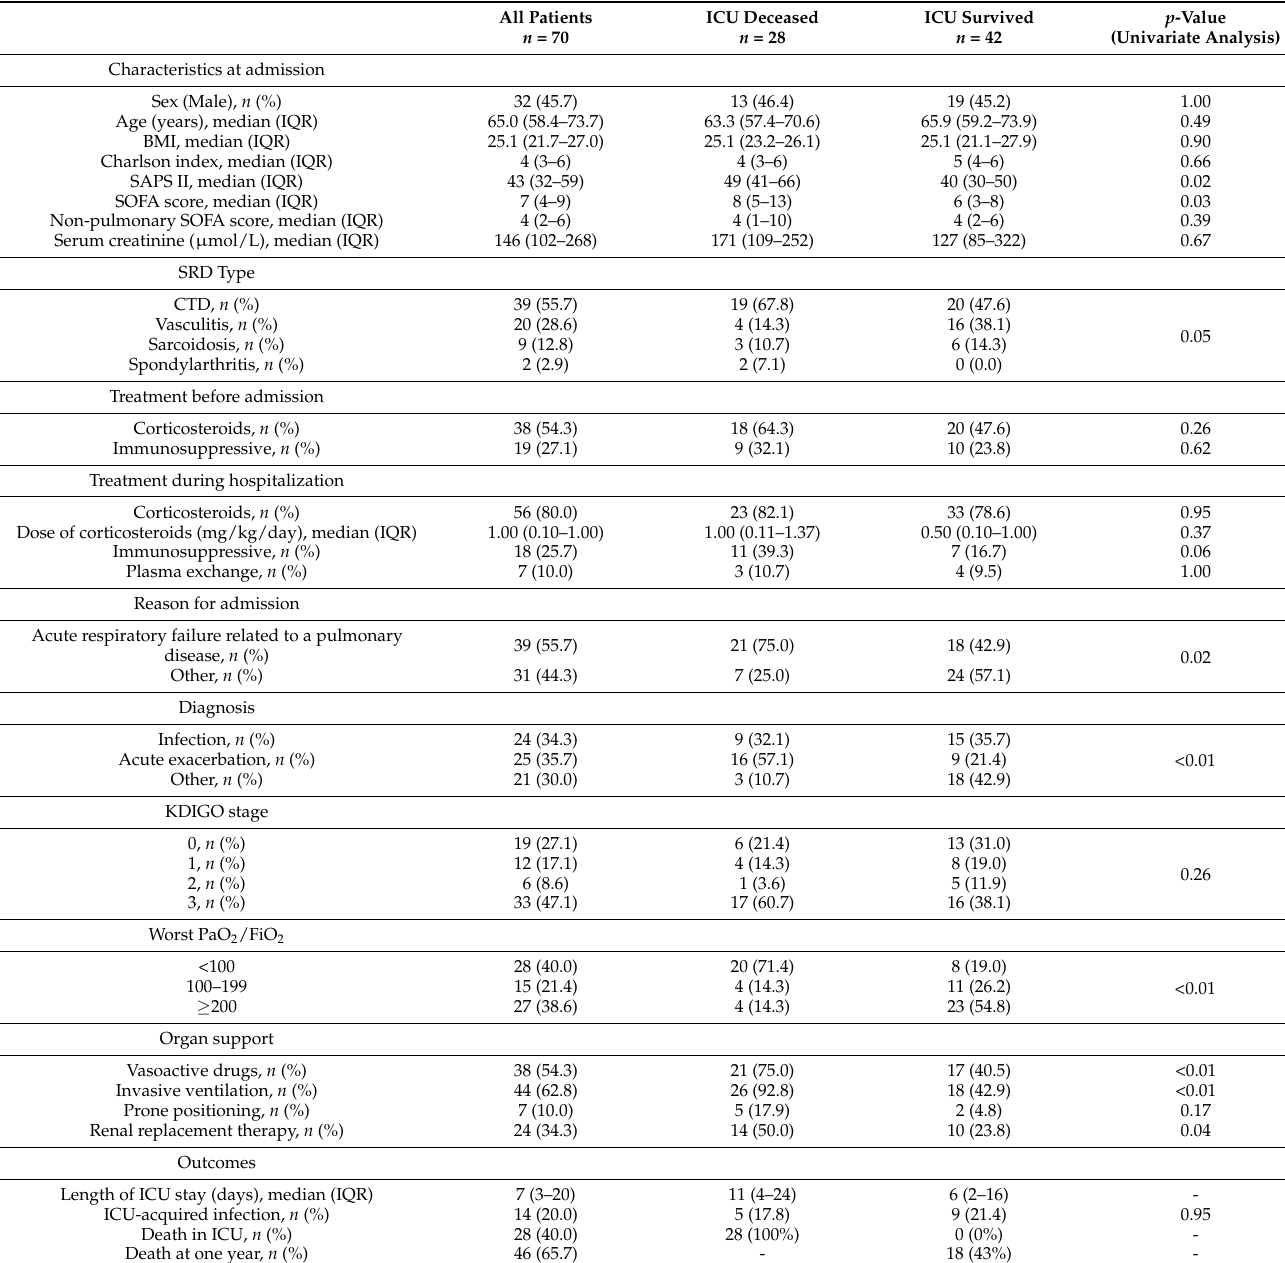
Table 1. SRD-ILD patients’